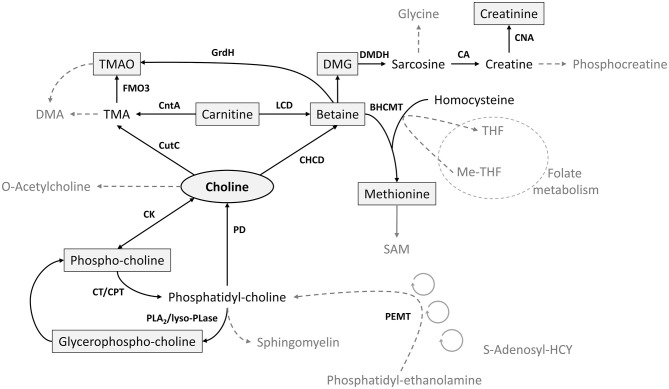
Key metabolic pathways of choline and its related metabolites (6–10). FMO3, flavin-containing monooxygenase; BHCMT, betaine-homocysteine methyl transferase; CA, creatinase; CAN, creatininase; CHCD, choline dihydrogenase; CK, choline kinase; CntA, carnitine monooxygenase; CPT, choline phosphotransferase; CT, cytidyltransferase; CutC, choline-TMA lyase; DMA, dimethylamine; DMDH, dimethylglycine dehydrogenase; DMG, dimethylglycine; GrdH, glycine-betaine reductase; LCD, l-carnitine dehydrogenase; lyso-PLase, lysophospholipase; PD, phospholipase; PEMT, phosphatidylethanolamine methyltransferase; PLA2, phospholipase A2; TMA, trimethylamine; TMAO, trimethylamine N-oxide.